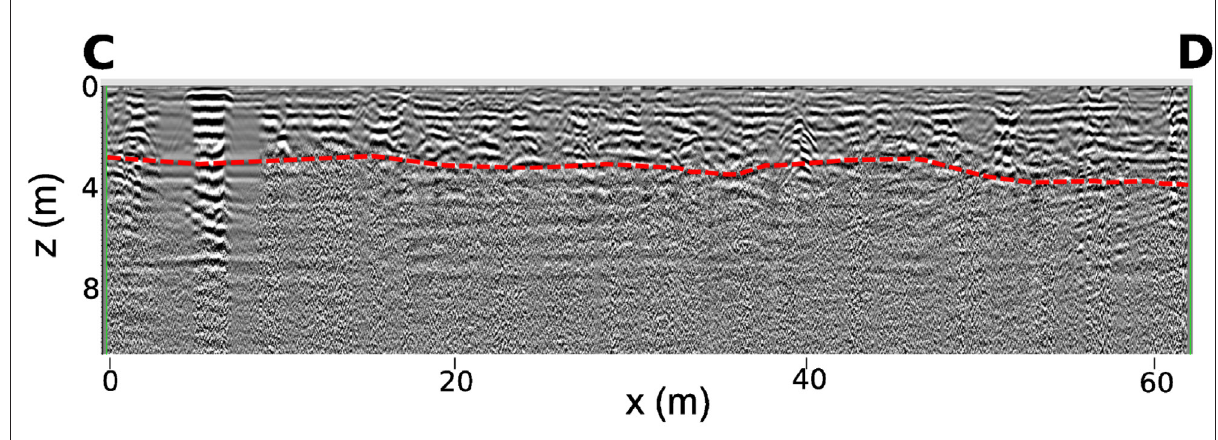
Figure 7. GPR section of line CD (80 MHz antenna). The red dashed lined indicates the limit of the anthropic